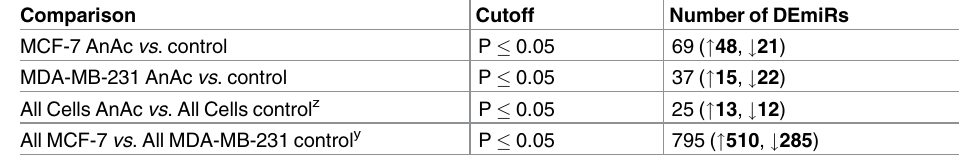
Table 1. Differentially expressedmiRNAs (DEmiRs). The log2-foldchangewith zero value in the control conditions was arbitrarily set to one and the maximum log2-foldchange value and those with zero value in the treatment conditions were arbitrarily set to the minimumlog2-foldchange value of minus one. The numberof differentially expressedgenes in each comparisonis shown and the number of upregulatedgenesindicated with the upwardarrow and downregulated genes indicatedby downward